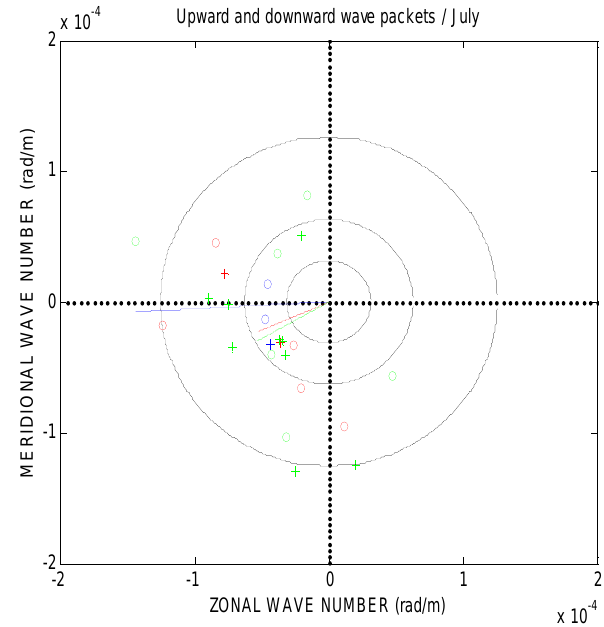
875 Fig.5b S ame as Fig.5a except for the month of July. Fig. 5b. Same as Fig. 5a except for the month of Fig. 5a. Plot of meridional wave number vs. zonal wave number of virtual gravity wave packets in the month of November. “o” stands Fig.5a Plot of meridional wave number .vs. zonal wave number of virtual gravity wave for upward, while “ + ” for downward propagating virtual gravity wave packets; blue denotes 1986; red denotes 1988; and green de- packets in the month of November. ‘o’ stands for upward, while ‘+’ for downward notes 1989. Colored lines represent the respective directions (not propagating virtual gravity wave packets; Blue color denotes the year of 1986; red amplitude) of background mean wind. The inner, middle and outer color denotes the year of 1988; and green color denoted the year of 1989. Colored black circles correspond to horizontal wavelengths of 200, 100, and 50km, respectively. straight lines represent the respective directions (not amplitude) of background mean 860 wind. The inner, middle and outer black circles correspond to horizontal wavelengths of 200, 100, and 50 km respectively.